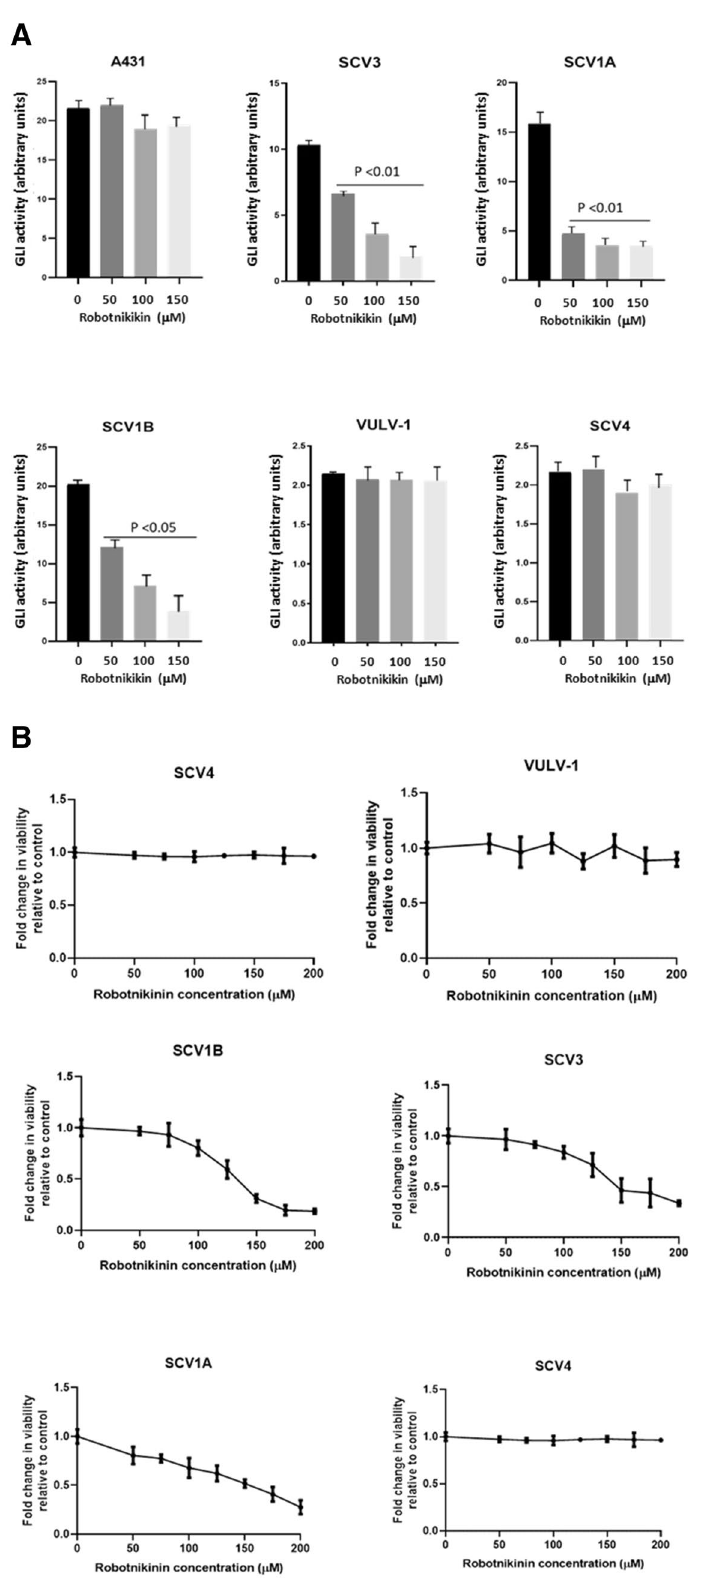
Figure 3. Treatment of Hh-dependent VSCC cells with the SHH antagonist, Robotikinin, attenuates GLI-reporter activity and cell proliferation. ( A ) Treatment of VSCC cell lines with the SHH antagonist, Robotikinin, led to a significant reduction in GLI-luciferase reporter activity in UM ‐ SCV ‐ 1A, UM ‐ SCV ‐ 1B and SCV3, but had no effect on A431, or the low baseline GLI- reporter activity in UM-SCV4 and UCI-VULV-1. ( B ) XTT assays showing a dose-dependent reduction in cell proliferation in Hh-dependent (UM-SCV-1A, UM-SCV1B, SCV3) but not Hh-independent (SCV-4, UCI-VULV1) VSCC cell lines treated with Robotikinin; Robotikinin had no significant effects on A431